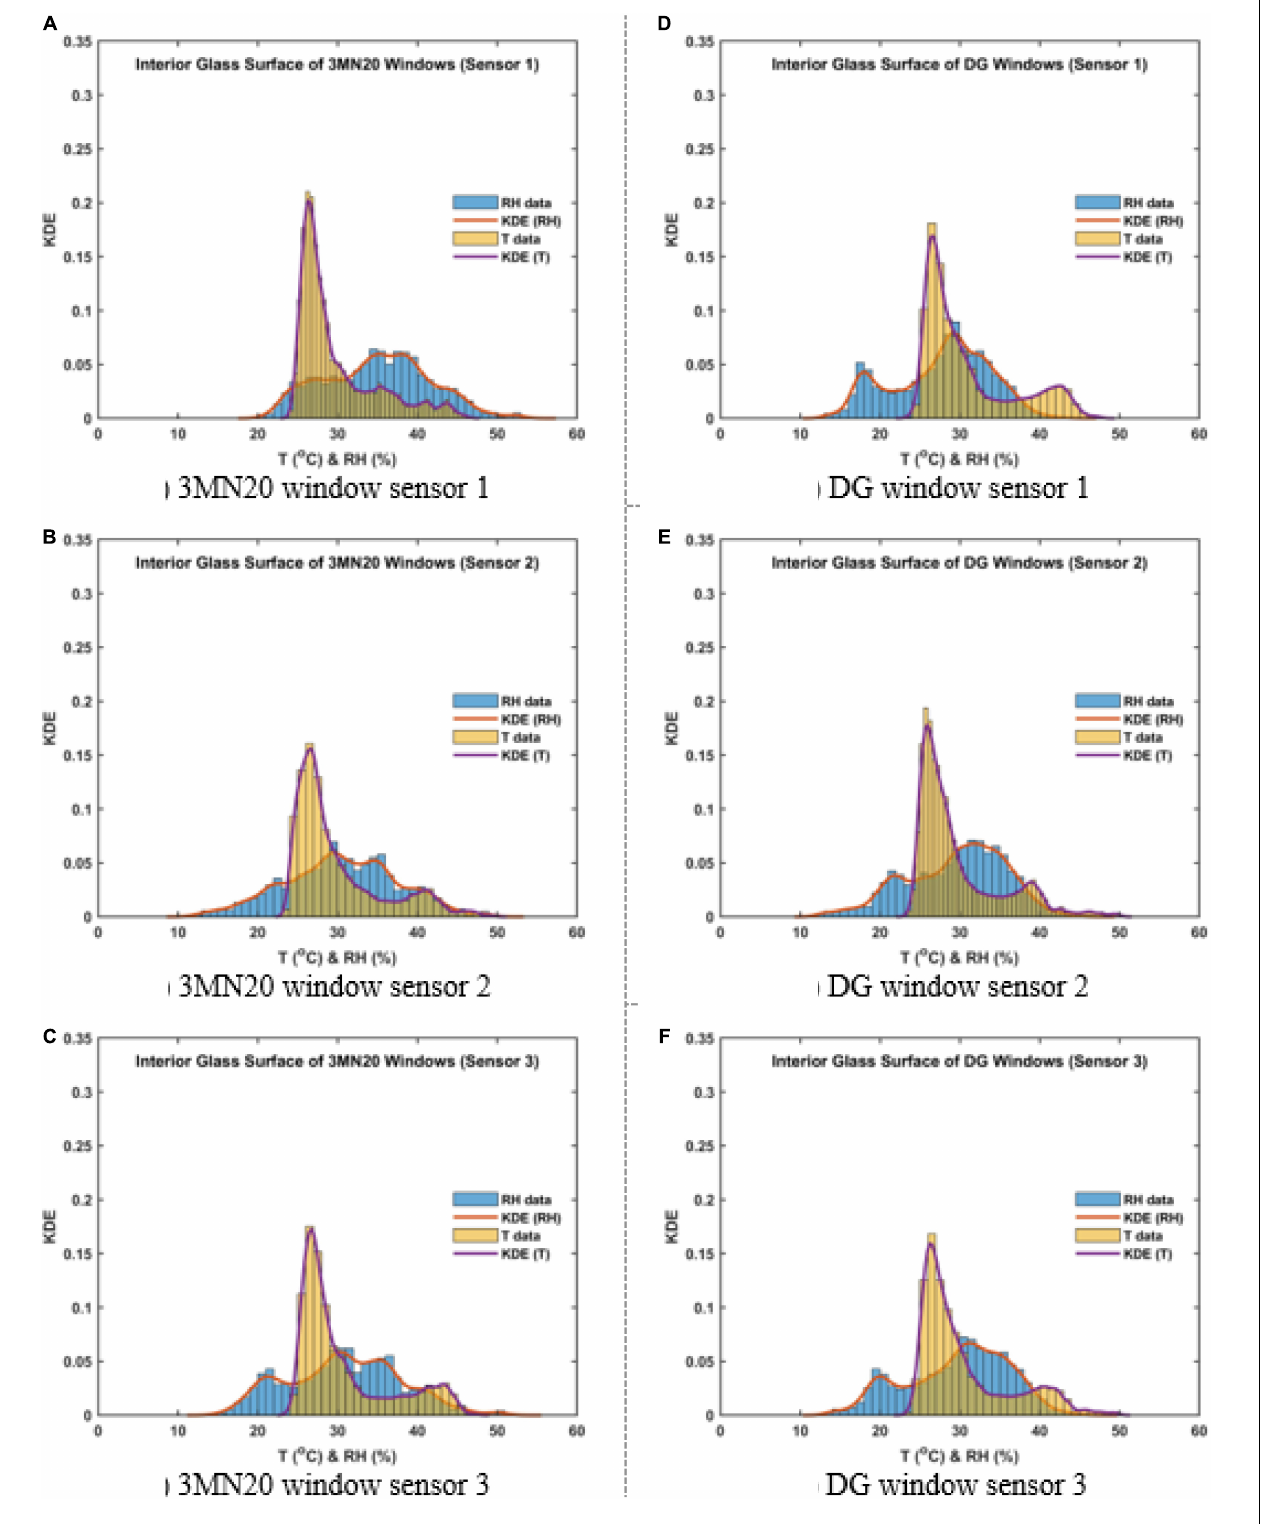
FIGURE 7 | Histograms and kernel density estimation (KDE) of temperature (T) and relative humidity (RH) for three DHT22 sensors on the interior glass surface of windows during the month of June 2019; (A–C) 3MN20 windows, and (D–F) DG windows.